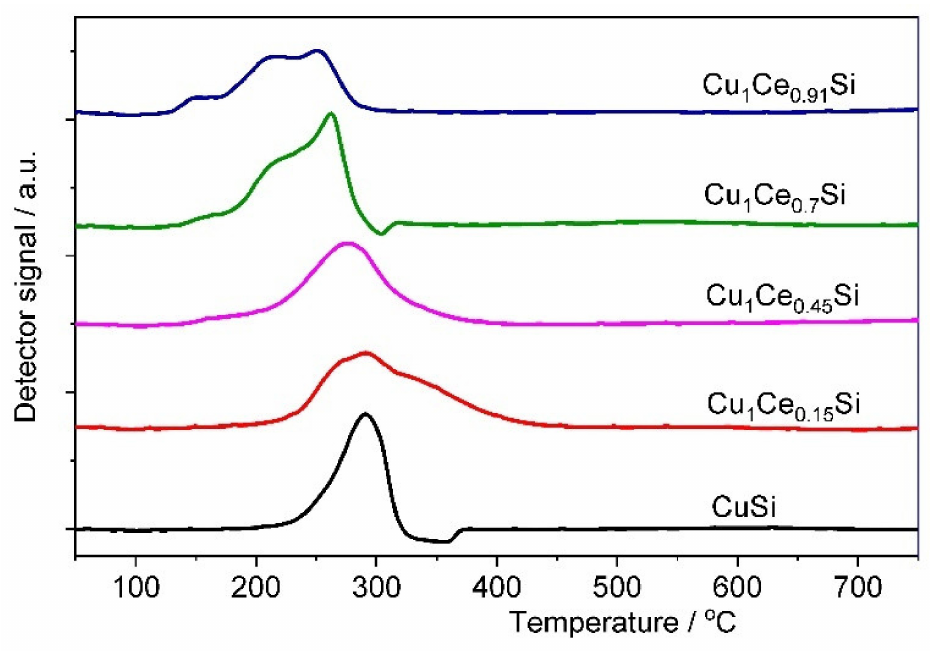
Figure 2. H 2 -TPR profiles of the as-prepared